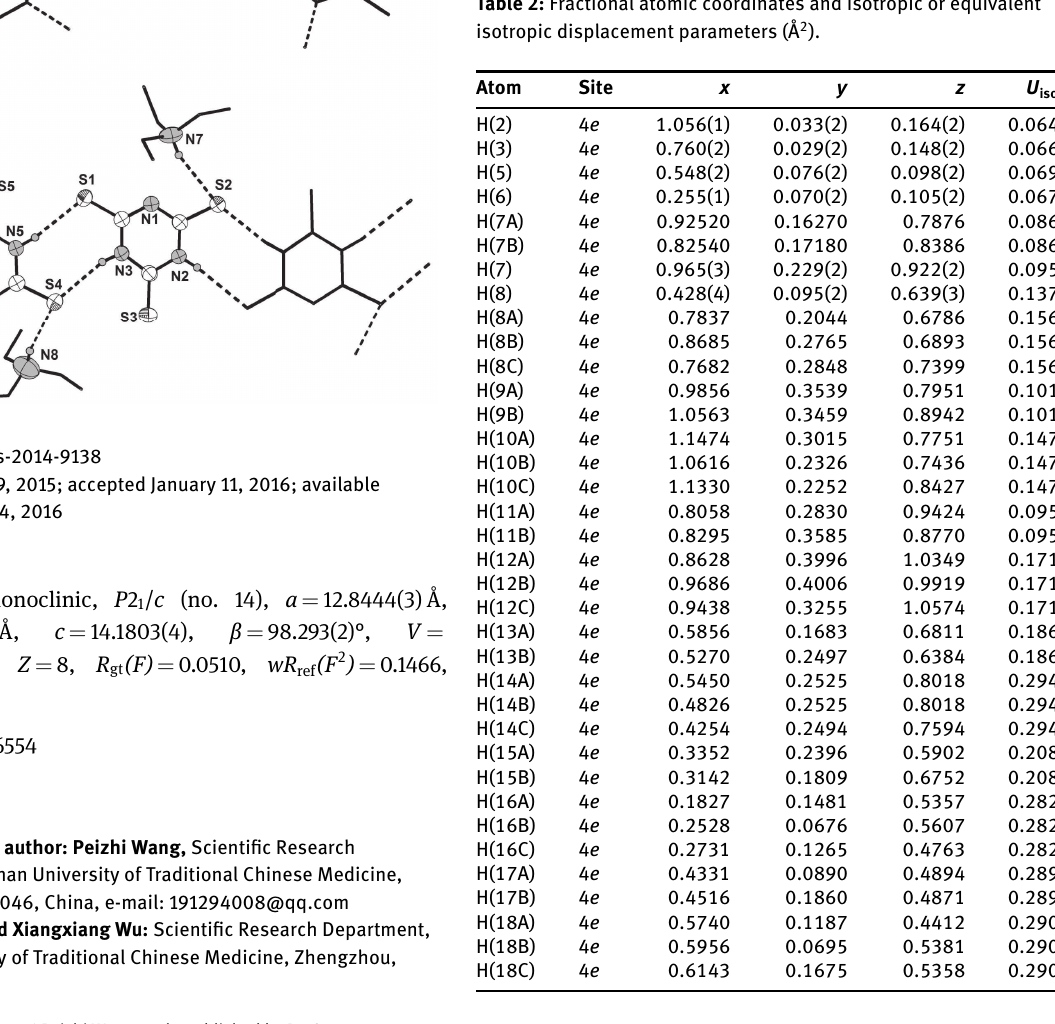
Table 2: Fractional atomic coordinates and isotropic or